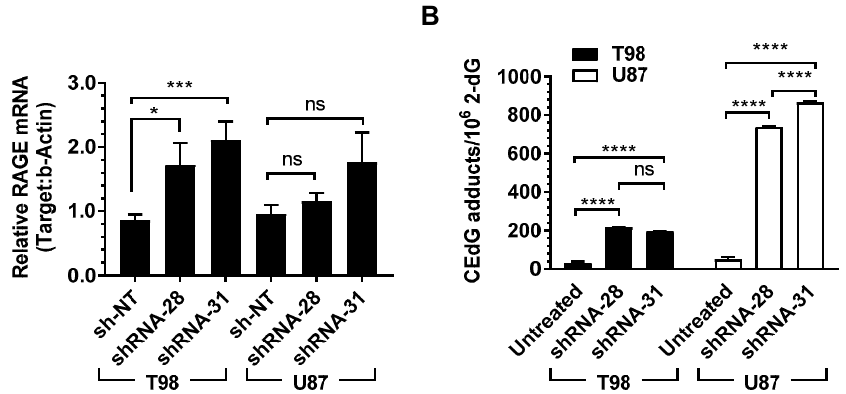
Figure 5. Knockdown of GLO1 induced RAGE expression and increased DNA-AGEs in GBM cells. ( A ) RT-qPCR analysis showed the efficiency of GLO1 knockdown in increasing RAGE transcripts in GBM cells. mRNA expression levels were normalized to β - actin and untreated cells, and compared with sh-NT cells. sh-NT: non-target short hairpin RNA (shRNA) virus infected cells; shRNA-28 and shRNA-31: GLO1-shRNA-28 and -31 virus infected cells. Data represent the mean of at least three independent determinations; ( B ) Quantification of ( R , S ) CEdG adducts in untreated or GLO1 knockdown T98 and U87 cells by LC-ESI-MS/MS. Error bars denote the mean ± SEM. Significant differences are indicated (* p < 0.05, *** p < 0.001, **** p < 0.0001, ns = not significant; two-way ANOVA with Tukey’s method to correct for multiple comparisons).